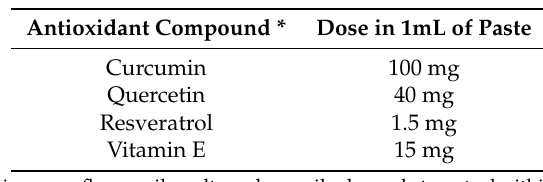
Table 1. Composition of the 15-mL syringe containing the antioxidant mixture formulated as a